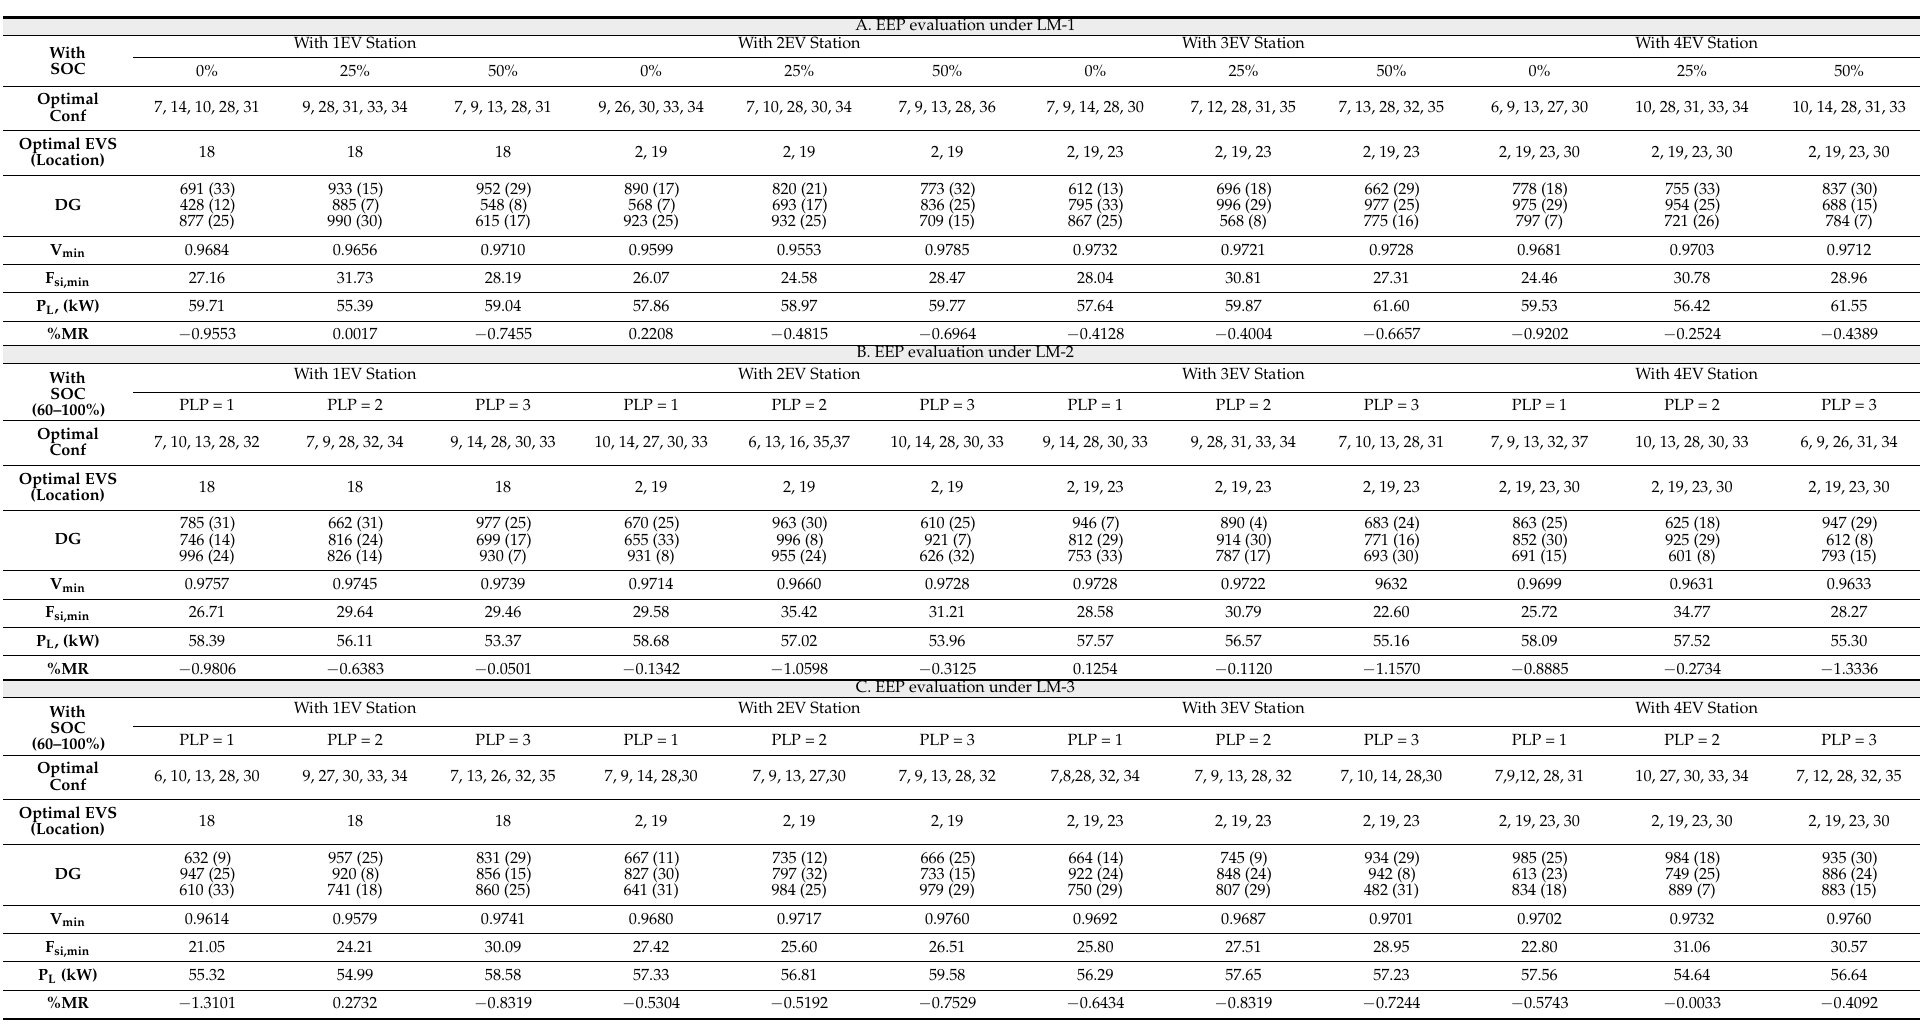
Table 9. EEP for Case-4 (ESS works as a